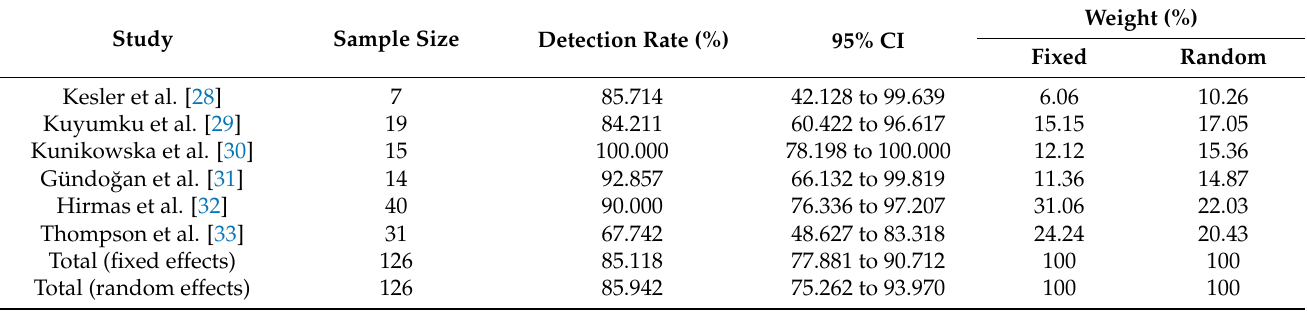
Table 4. Results of